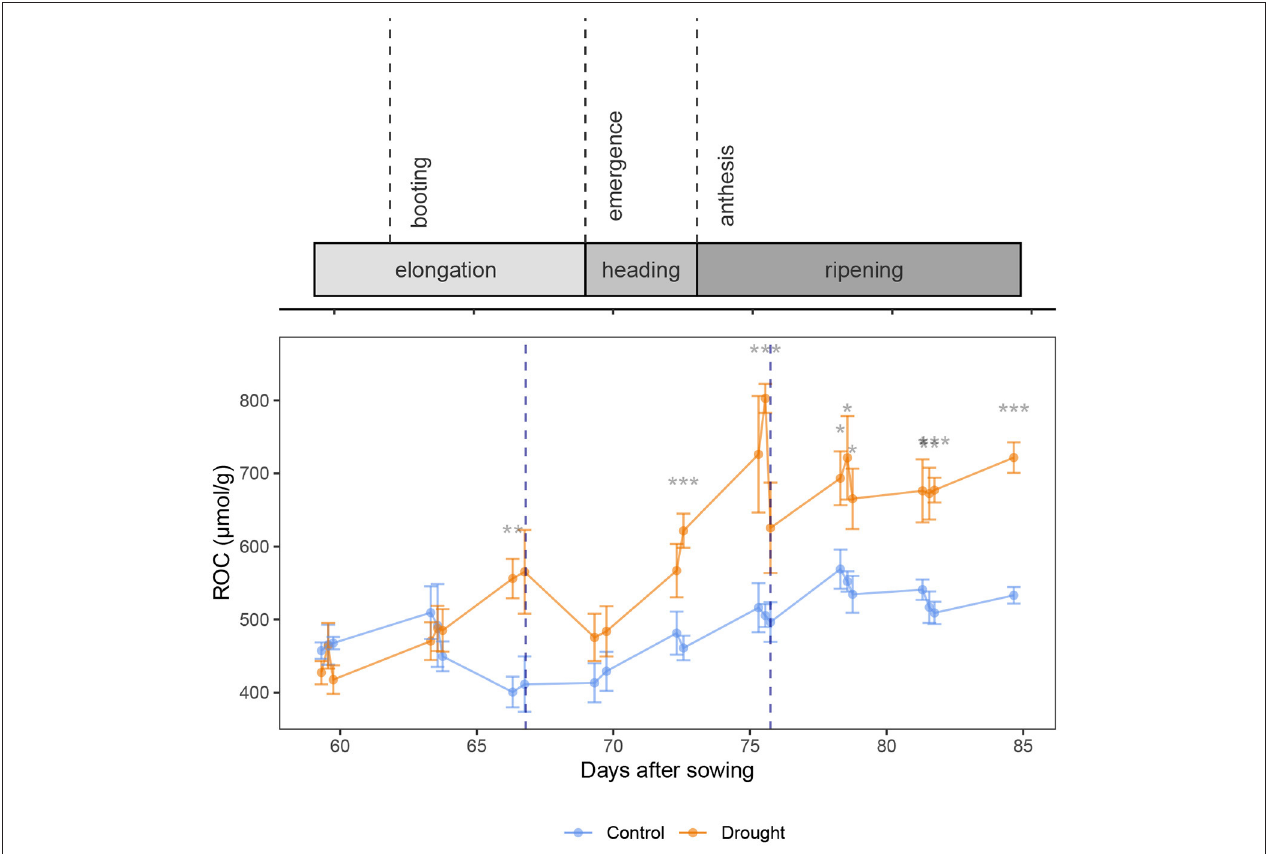
FIGURE 5 | Relative Osmolyte Content (ROC) over time in wheat stems, visualizing the osmotic adjustment. Rewatering events are marked with a blue dotted line. The control and drought treatment are depicted in blue and orange, respectively. Mean ( n = 5) and standard error are depicted and the means are connected with lines to improve the visibility of the trends. Significant differences between the control and drought treatment are indicated below the measurements. Significance levels: * p < 0.05, ** p < 0.01, *** p <